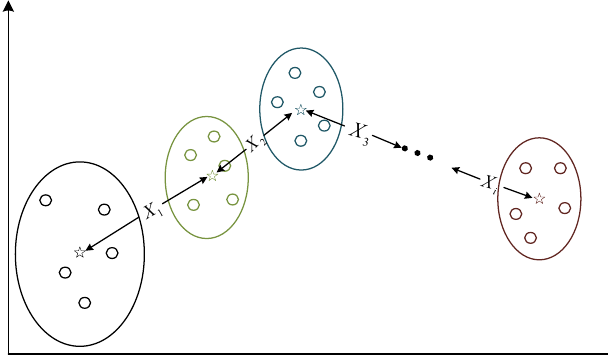
Figure 6. Schematic diagram of dynamic centroid algorithm.